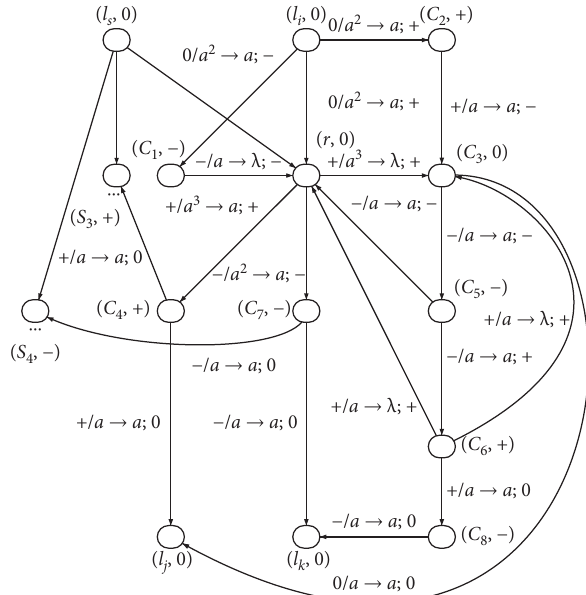
Figure 2: SUB module (simulating l